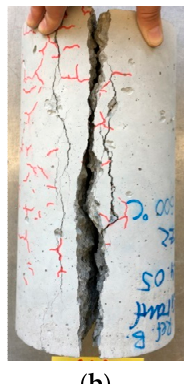
Figure 6. ( a ) Test setup and ( b ) typical failure mode of concrete cylinders used for determining split tensile strength after exposure to a temperature of 600 °C.